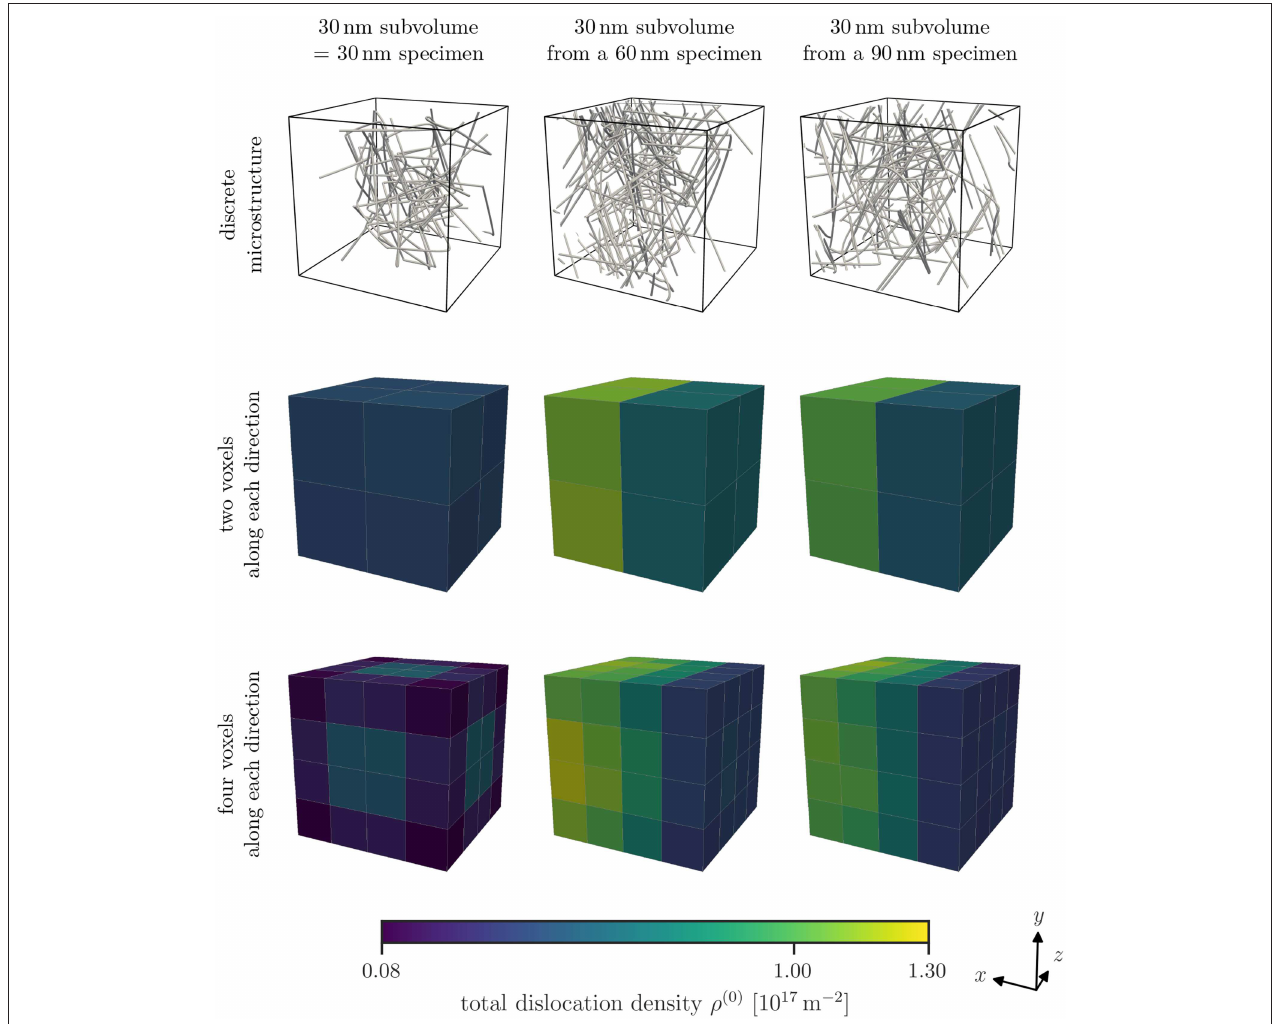
FIGURE 3 | Examples of discrete microstructures found within the inspected subvolumes of the different specimen sizes can be seen in the top row. Note that the size of the subvolumes is the same, but the specimen they were taken from are different (see Figure 1 ). The open surface common to all subvolumes irrespective of the specimen size is in negative x -direction, in this case, to the right. Average total dislocation density ρ (0) for each studied specimen size and two or four voxels per direction as discretization are shown in the bottom